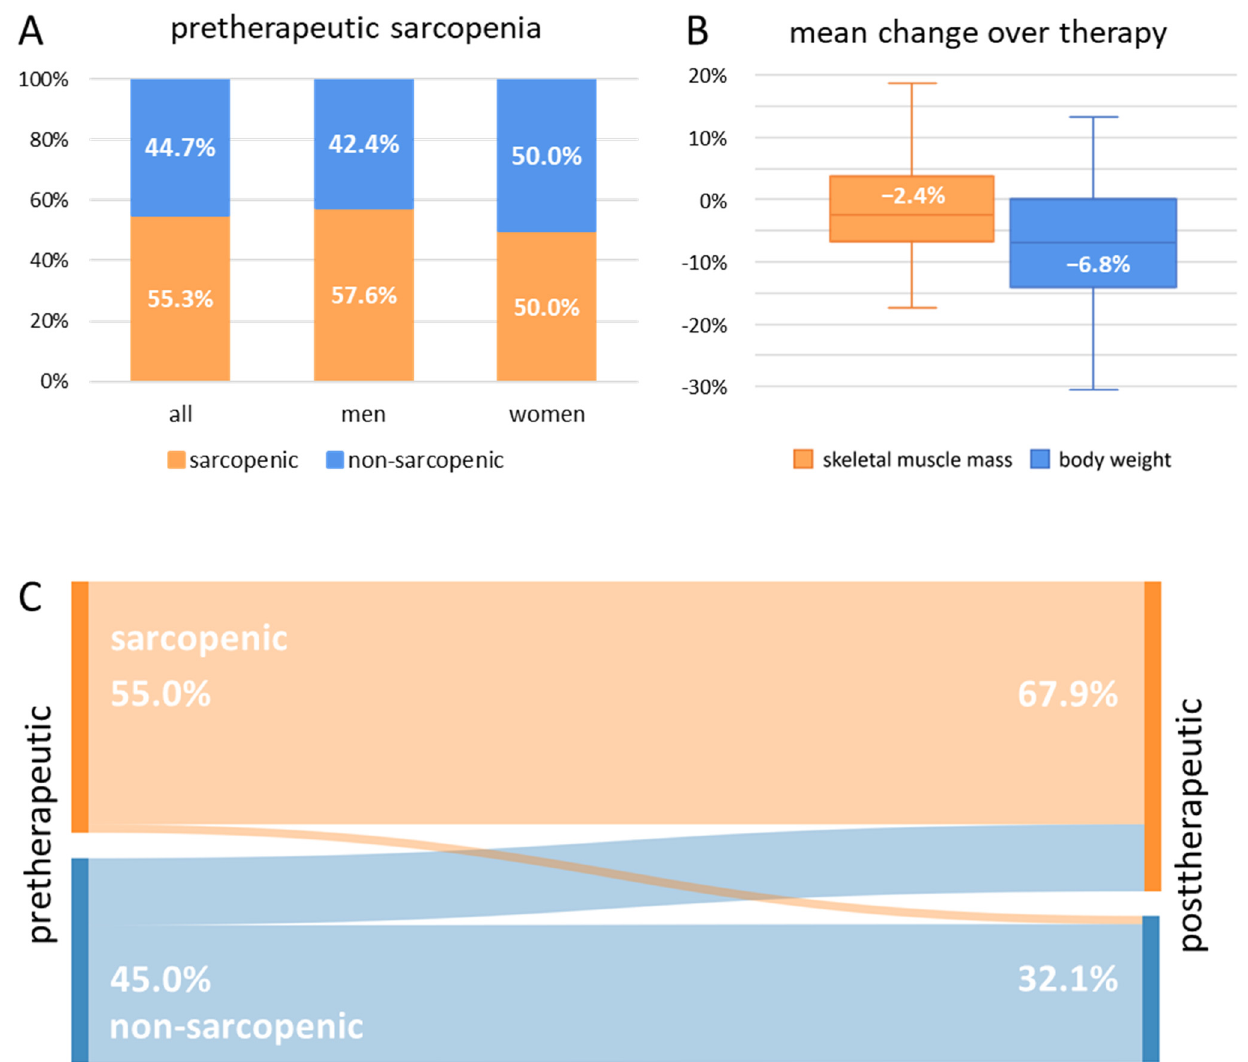
mass with a median of 2.1 and 1.9 standard deviations below the average for L3MA and L3MI of the reference cohort, respectively (Figure 2) [22].